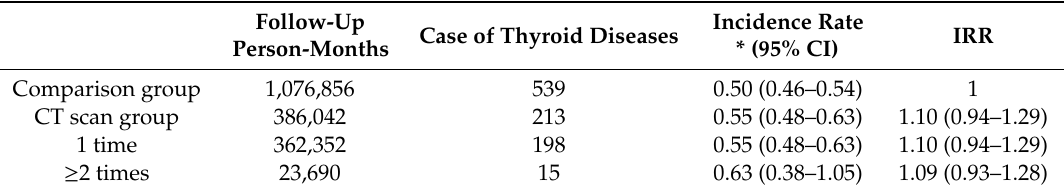
Table 2. Cumulative incidence rate of thyroid diseases.